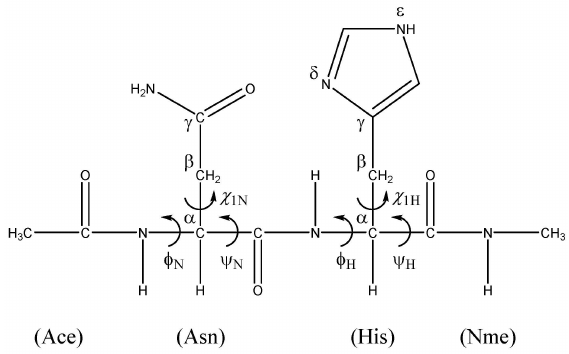
Figure 1. The model compound (Ace–Asn–His–Nme) used in the present study. Both the Asn and His residues are in the L -configuration. The ϕ N (C–N–C α –C) and ψ N (N–C α –C–N) dihedral angles characterize the main-chain conformation of the Asn residue, and ϕ H and ψ H are the corresponding dihedral angles of the His residue. The χ 1N and χ 1H dihedral angles (N–C α –C β –C γ ) are for the side chains of the Asn and His residues,